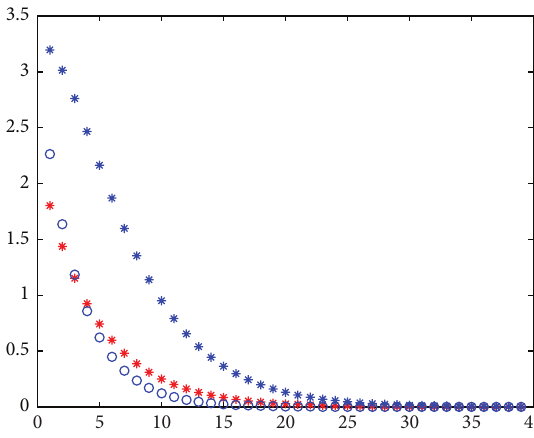
Figure 5: The errors of EMA and Jacobi iteration.